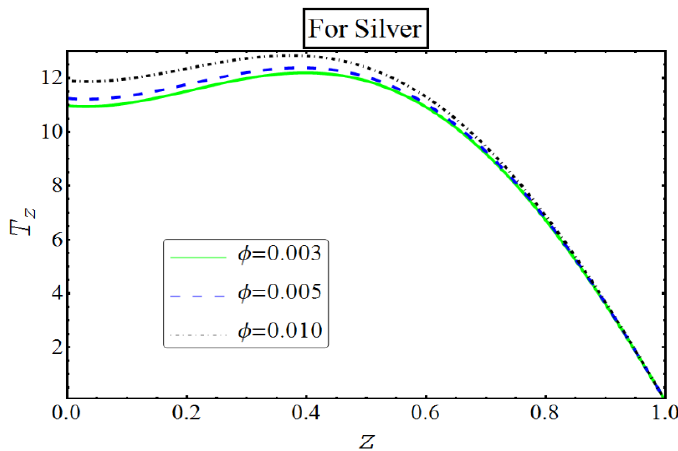
Figure 26. Variation of 𝑇 𝑧 on concentration particles. Coatings 2018 , 8 , x FOR PEER REVIEW